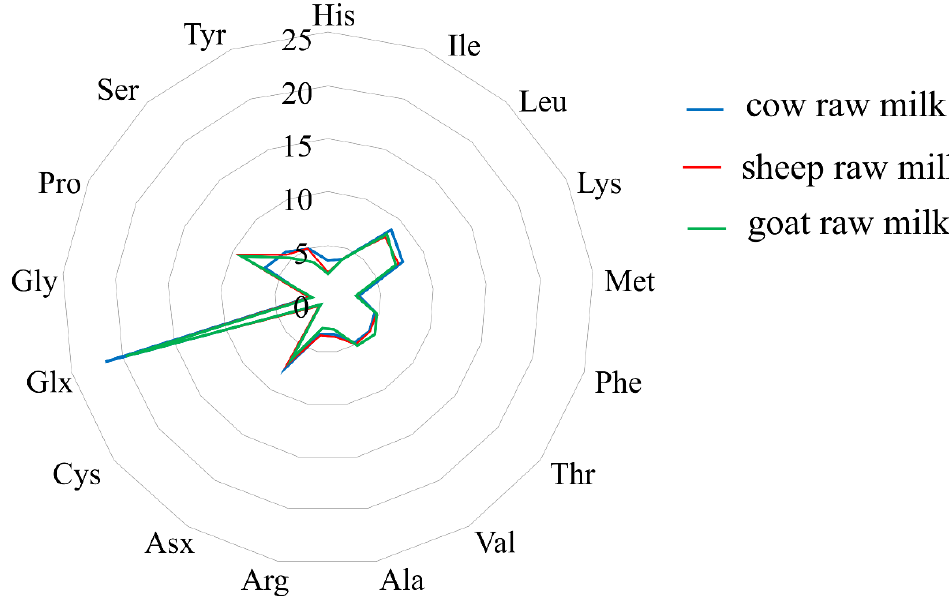
Figure 3. Radar graph of the average raw milk amino acid composition from three different mammal species (cow, sheep and goat), raised in two localities of ‘Alto Casertano’.